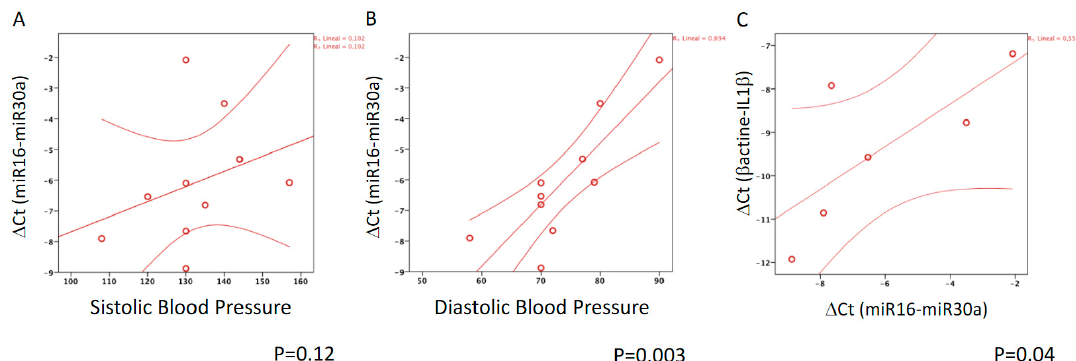
Figure 5. Expression of hsa-miR30a-5p was significantly correlated with diastolic blood pressure and with IL1 β levels. Scatter plot showing the relationship between hsa-miR30a-5p and blood pressure (panels ( A , B )) and IL1 β expression (panel ( C )). A straight line shows the linear trend and the correlation coe ffi cient (R 2 ). The Spearman’s rank order correlation was